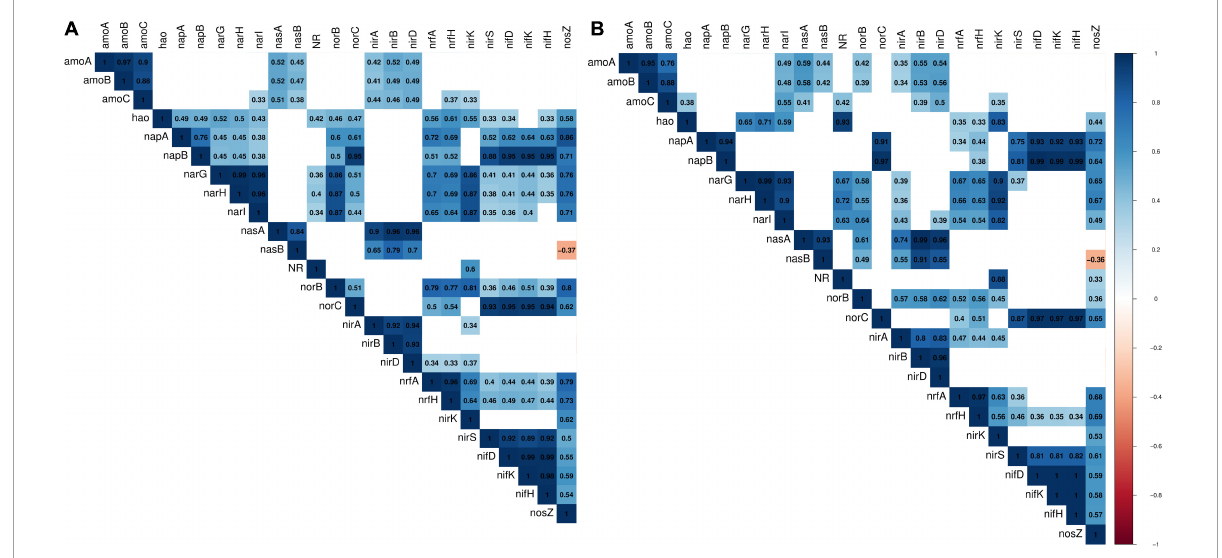
FIGURE3 Gene with gene correlation plots panel (A) is for gene richness and panel (B) is for gene abundance. The red gradient indicates negative correlation, while the blue gradient indicates positive correlation (up to + 1). Non-significant ( p -value > 0.05) correlations were not